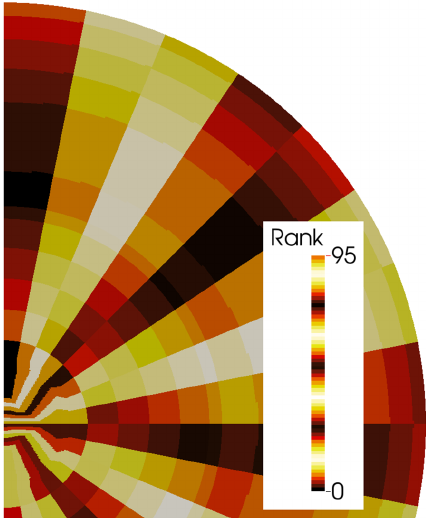
Figure 5. A typical mesh decomposition for the PREM model run- ning at a dominant period of 9s on 96 cores. Load balancing is ex- act, and the arbitrary permissible multiplication between the num- ber of horizontal and radial slices guarantees flexibility for adapting numerical settings to existent hardware